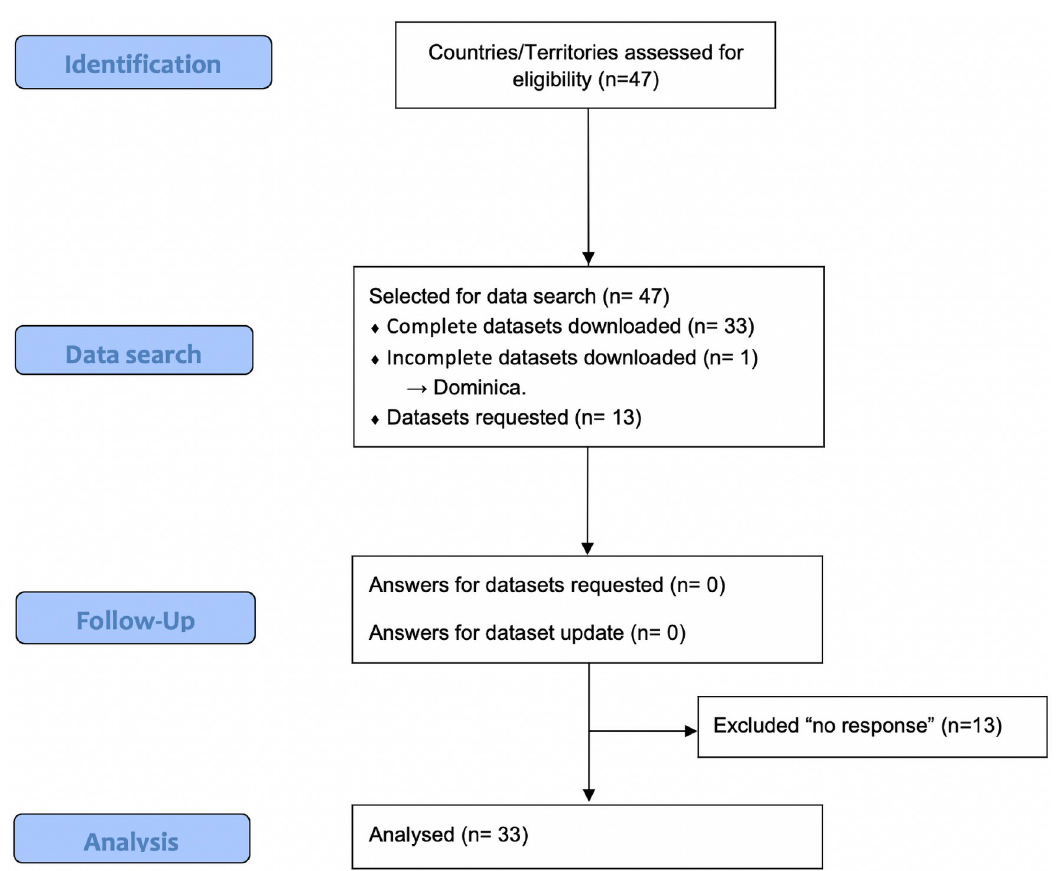
Fig 1. Flowchart of procedures for data